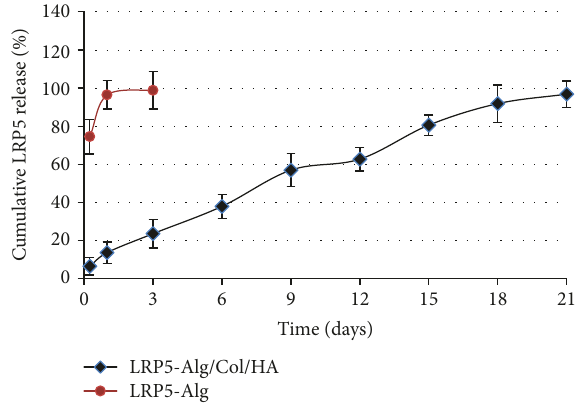
Figure 4: In vitro release of LRP5-Alg/Col/HA loaded with 40ug/mL LRP5.